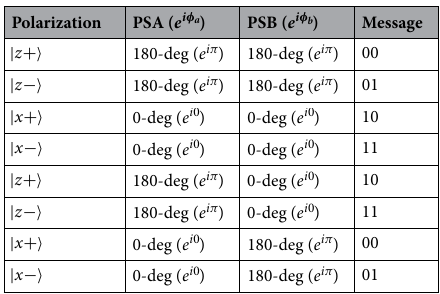
Table 1. Encoding/decoding table of Scheme